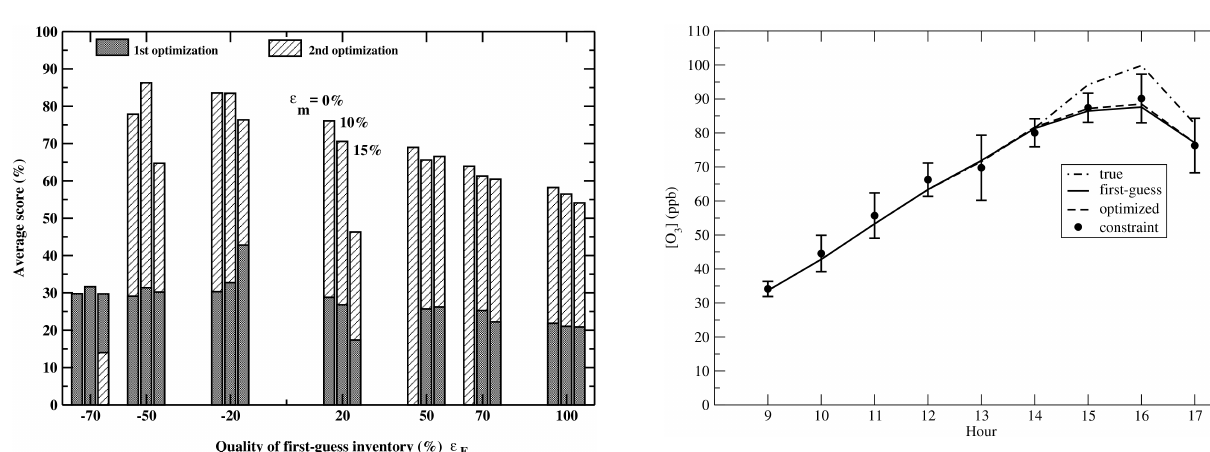
Fig. 9. Average scores (%) after a first and then a second cycle of kriging-optimization using NO constraints.